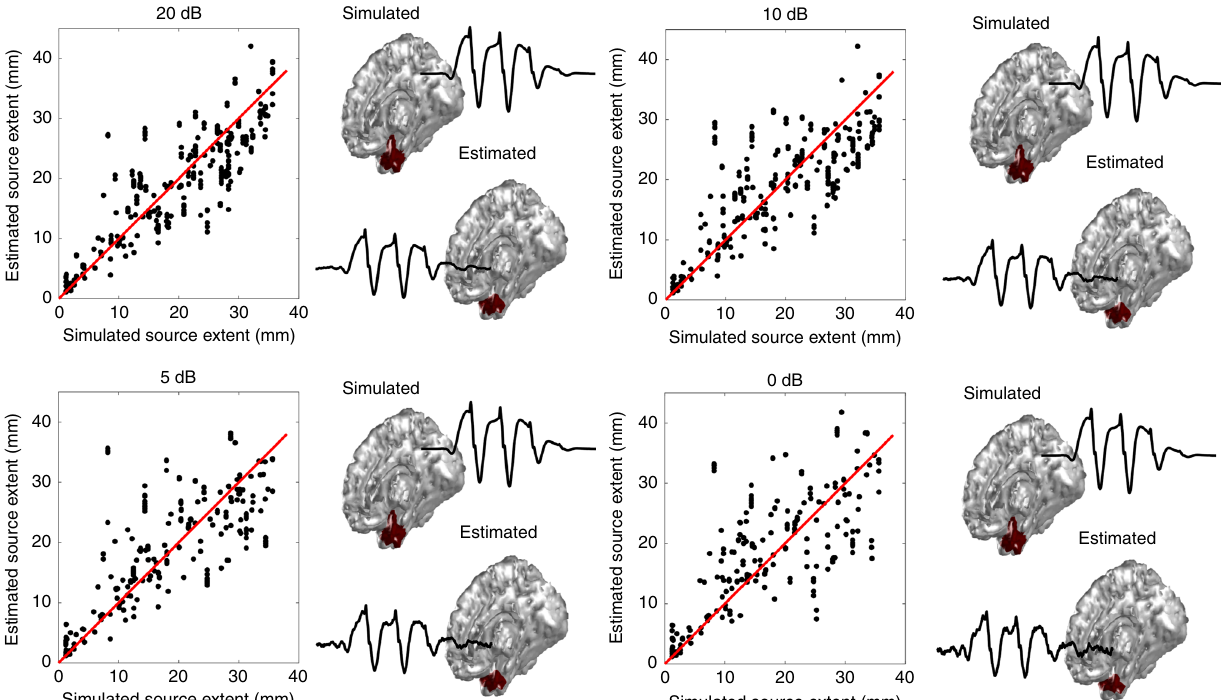
Fig. 2 Monte Carlo simulation results of extent estimation. The results of estimated extent from our FAST-IRES algorithm is plotted against the simulated sources ’ extent for four different SNR conditions. An example of a mesio-temporal source is also presented for all the SNR conditions, along its estimated time-course of activity. The red line in the four plots is the identity line and is provided for reference. Source data are provided as a Source Data fi